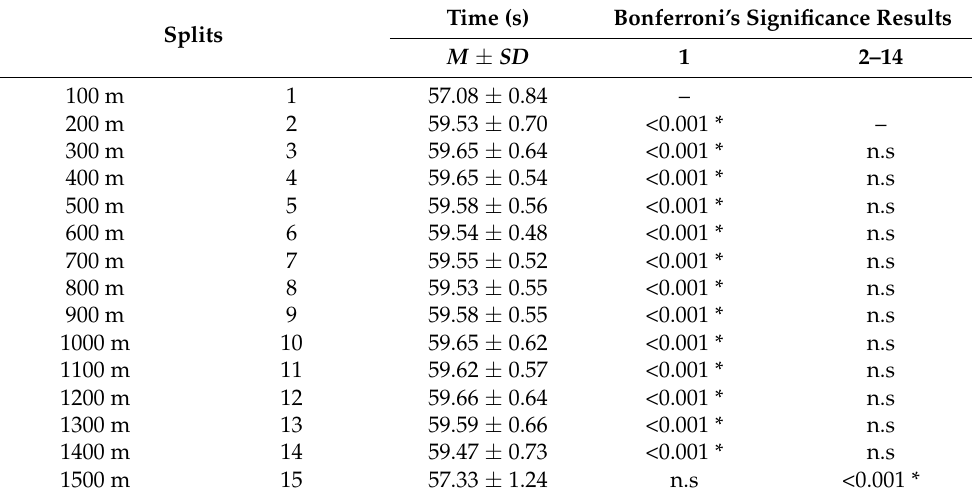
Table 4. Summarized post hoc Bonferroni’s and Scheff é ’s tests analysis of the 100 m split of the 1500 m swimming performance. Time Splits